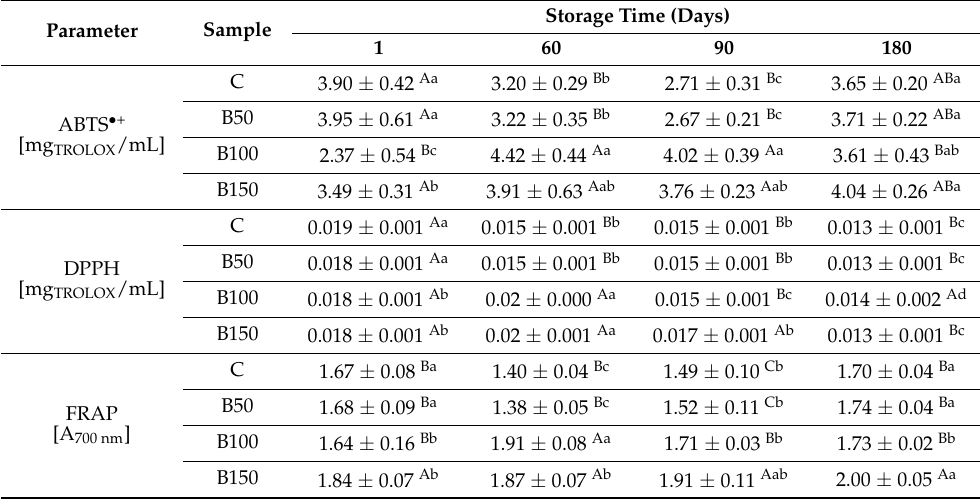
Table 4. Antioxidant abilities of canned meat fortified with the extract from black currant leaves during 180 days of storage (4 ◦